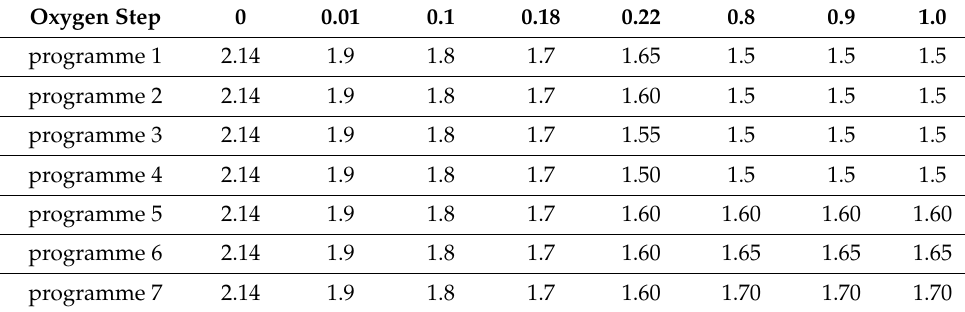
Table 5. The oxygen lance height schemes